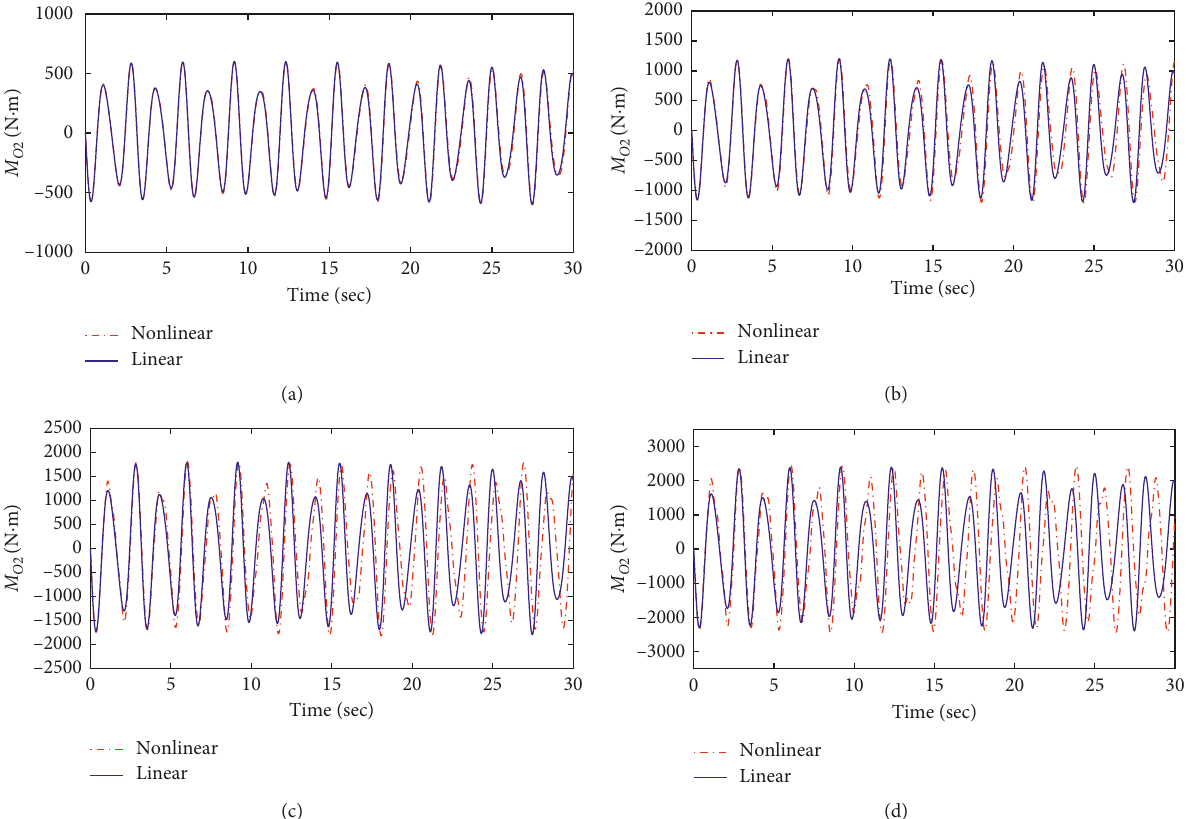
Figure 21: Time history of the resultant hydrodynamic moment about the θ � π /2 axis under the lateral harmonic excitation for ω � 6rad/s � 0.01m (a), 0.02m (b), 0.03m (c), and 0.04m (d), and X 0